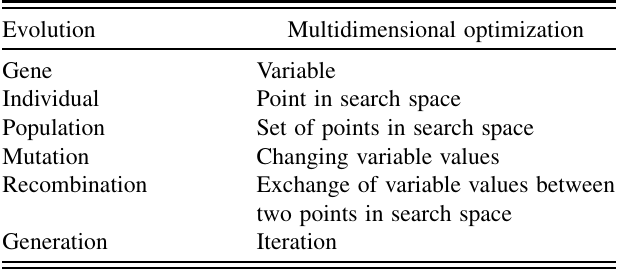
TABLE I. Correspondence between evolution and multidi- mensional